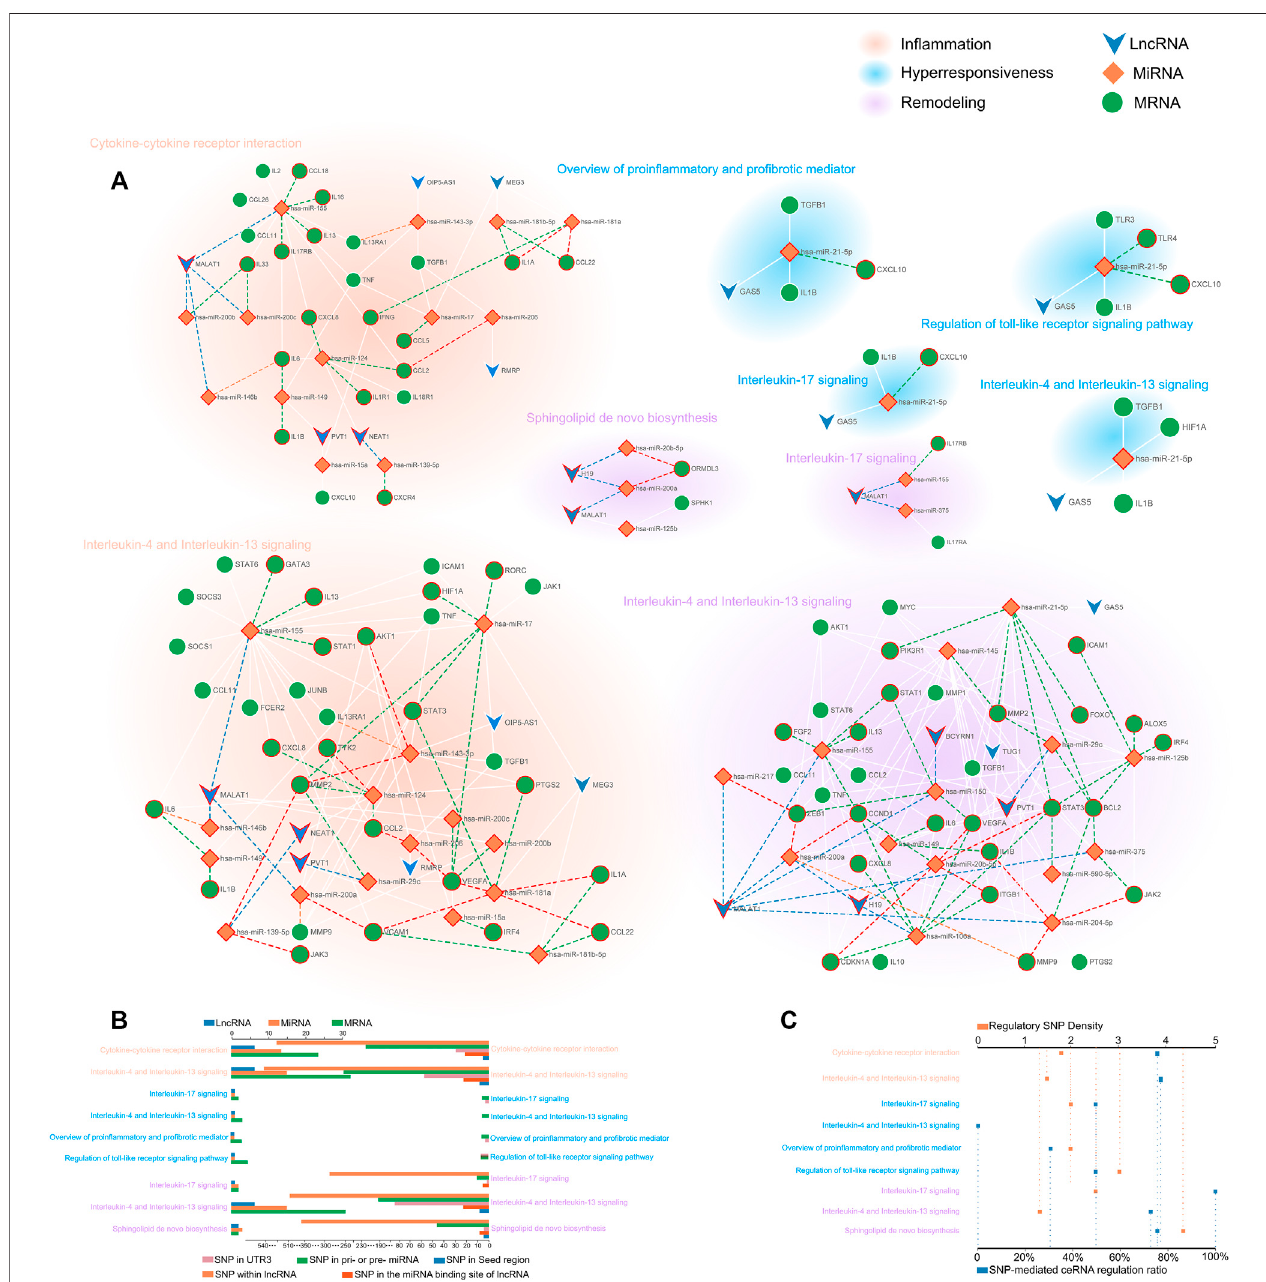
FIGURE 3 | The comprehensive disease regulatory network and information decoding. (A) CSSPN. Green circle, orange rhombuses, and blue inverted triangles representmRNAs,miRNAs,andlncRNAsrespectively.TheSNPslocatedinlncRNA,pri-/pre-miRNA,andthe3 ′ UTRofmRNAwereshownwiththeredcirclearoundthe mRNAs, miRNAs, and lncRNAs. The SNPs within the 3 ′ UTR of mRNA, the seed region of mature miRNA, and the miRNA binding site on lncRNA were exhibited with green,orange,andbluedashlinesrespectively.ThereddashlineindicatestheseedregionofmaturemiRNAand3 ′ UTRofmRNAcontainSNPs,whichcouldaffect miRNA-mRNA binding. (B) The multi-bar plot shows gene mapping and SNP mapping information pathways. The top and bottom axis represented the number of mapping genes and mapping SNPs respectively. (C) The dot plot of regulatory SNPs density and ceRNA regulation with SNP ratio. The top axis showed the density of regulatory SNPs. The percentage represented by the bottom axis re fl ects the proportion of ceRNA regulation with SNP in the total ceRNA regulations.